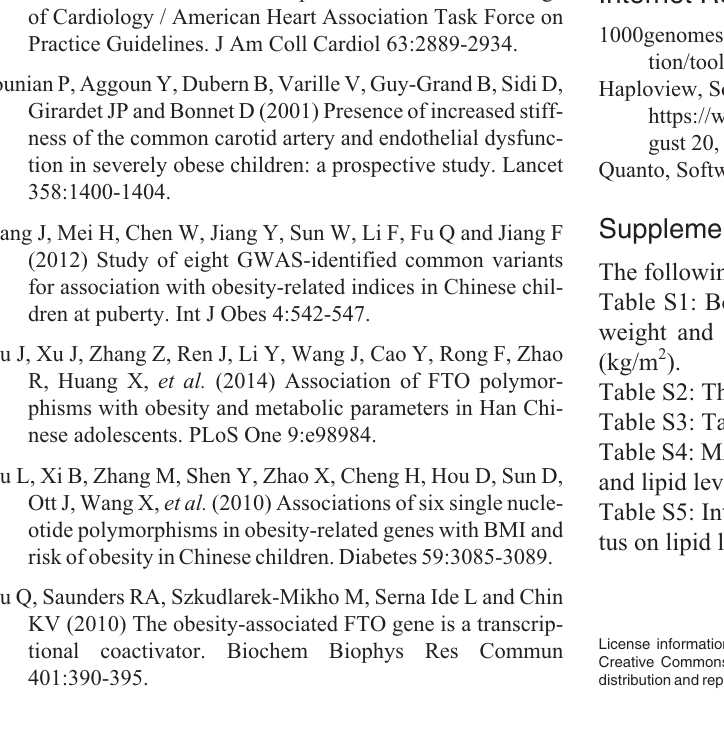
Table S1: Body mass index reference for screening over- weight and obesity in Chinese children and adolescents (kg/m 2 ). Table S2: The effect of FTO on lipid levels. Table S3: Tanner stage in boys and girls. Table S4: MAF of studies on the association between FTO and lipid levels. Table S5: Interactions between rs6499640 and obesity sta- tus on lipid